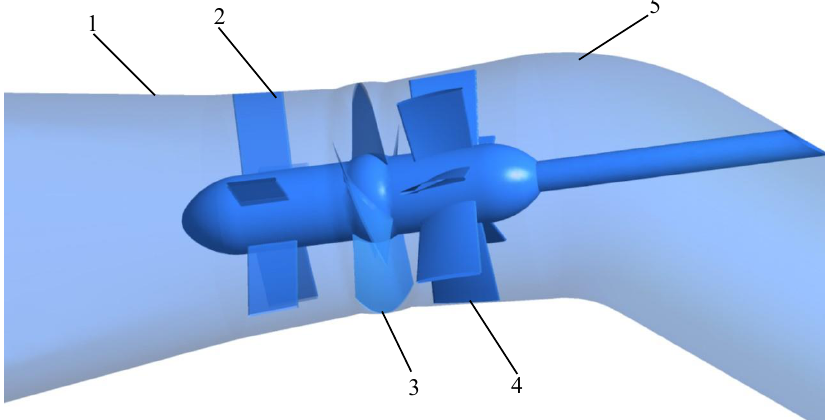
Figure 1. Flow channel diagram. (1) Inlet channel, (2) front guide vane, (3) runner, (4) guide vane, (5) outlet channel. Table 1. Relevant design parameters of the pump.